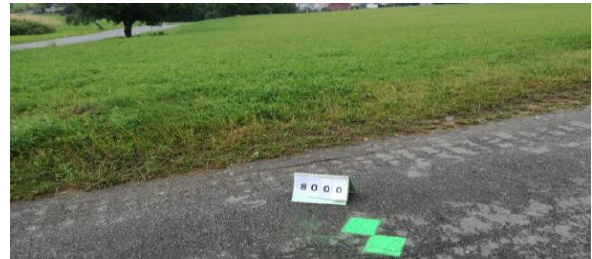
Figure 2 – targeting of the initial point No. 8000 on the